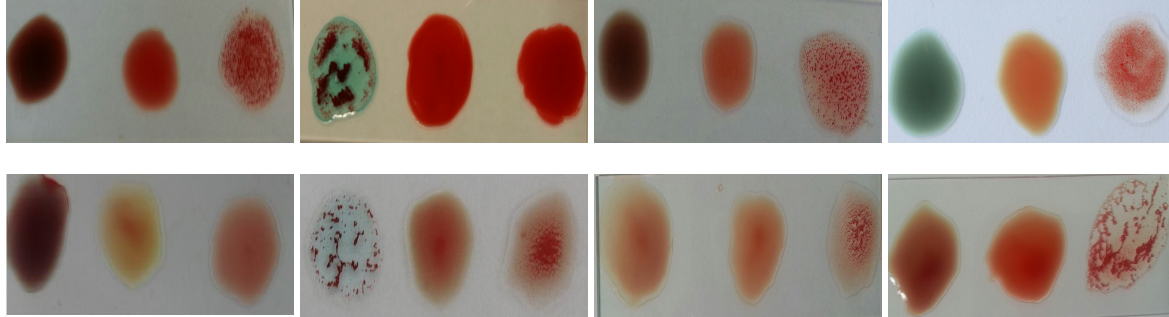
Figure 6. Blood samples with brightness